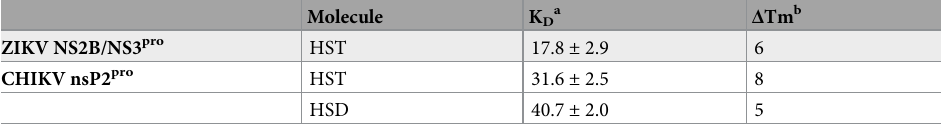
Table 2. Results summary of the fluorescence spectroscopy experiments of ZIKV NS2B/NS3 pro and CHIKV nsP2 pro with HST and